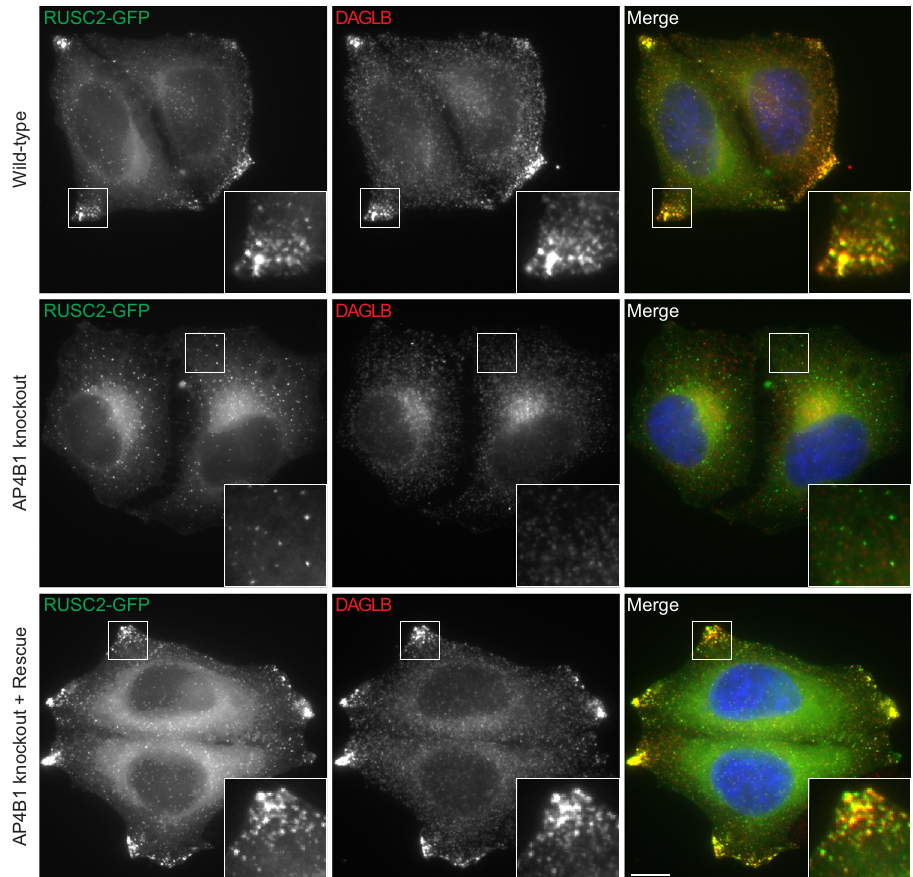
Fig. 3 Overexpression of the AP-4 vesicle transport adaptor RUSC2 drives DAGLB to the cell periphery. Wide fi eld imaging of HeLa cells stably expressing RUSC2-GFP (green), labelled with anti-DAGLB (red). Top panel, wild-type; middle panel, AP4B1 knockout; lower panel, AP4B1 knockout with transient expression of AP4B1 (rescue). In the merged image, DAPI labelling of the nucleus is also shown (blue). The insets show accumulation of RUSC2- GFP-positive and DAGLB-positive puncta at the cell periphery, and this only occurred in the presence of AP-4 (wild-type and rescue). Images are representative of at least 20 images per condition, including three independent rescue transfections. Immuno fl uorescence and microscopy were performed independently from two technical replicates of separate coverslips from the same batch of cells. Consistent results were observed for cells expressing RUSC2 with an N-terminal GFP tag and with AP4E1 knockout (data available at https://zenodo.org/record/5696988). Scale bar: 10 µ